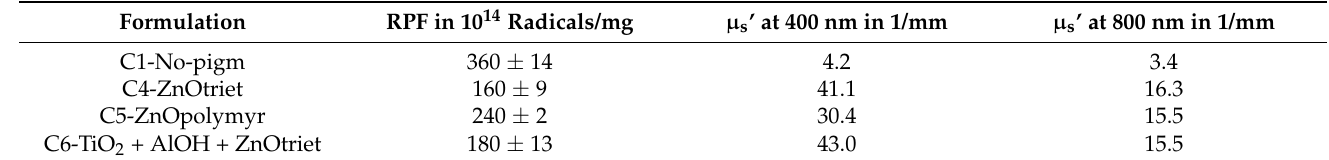
Table 4. Determination of the RPF of different cream formulations and the scattering coefficient µ s ’ at 400 and 800 nm of the investigated formulation.